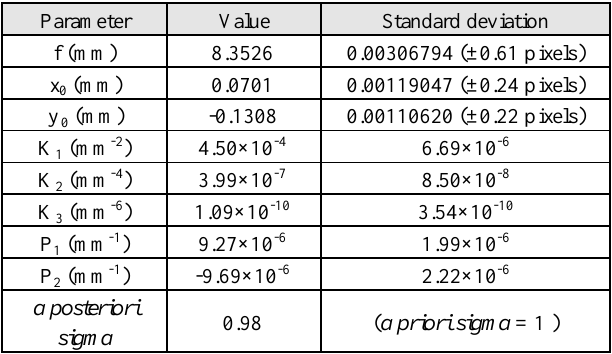
Figure 3. Sequence of image processing to extract tree stems: (a) Rectified and smoothed image in gray levels; (b) detection of straight structures; (c) Stem labelling windows.